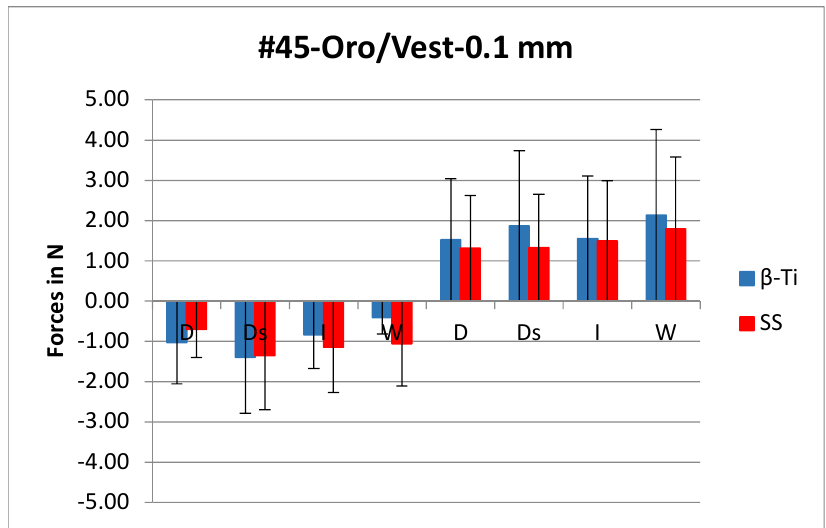
Figure 3. Graphic representation of the forces generated at the 0.1mm of the orovestibular movement of the premolar (#45). SS: stainless steel; β -Ti: beta titanium; D: discovery ® MIM; Ds: discovery ® smart; W: WiN, I: Incognito™; N: Newton.